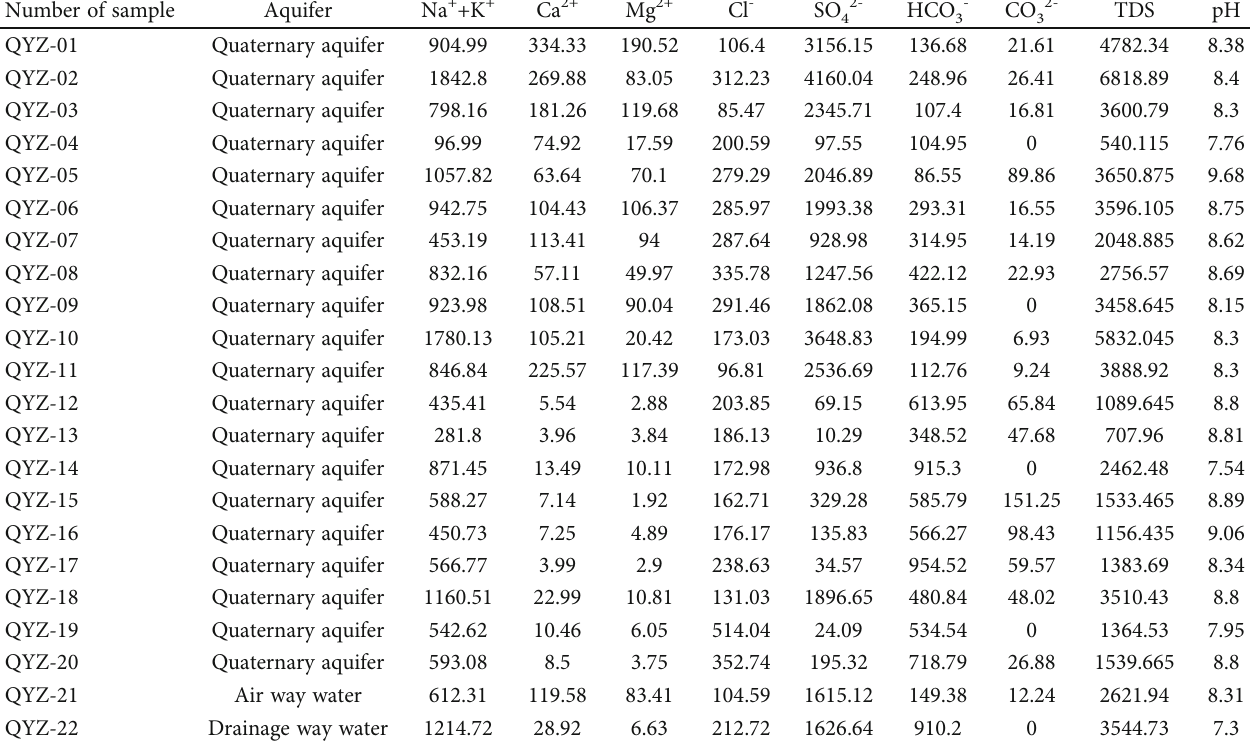
Table 2: Composition of major ions in loose and coal bearing sandstone aquifers.